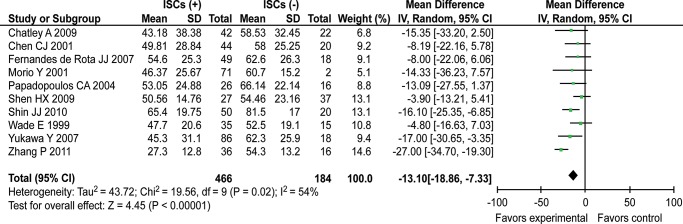
The forest plot of T2-weighted magnetic resonance imaging intramedullary signal changes (+) versus intramedullary signal changes (-).